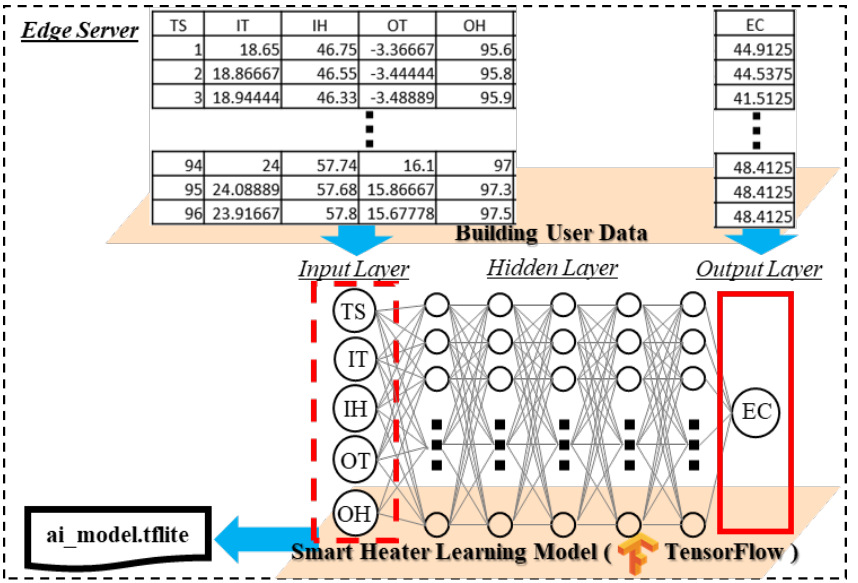
Figure 9. Implementation of the Deep Neural Network (DNN) model using building user data for predicting heater energy consumption.